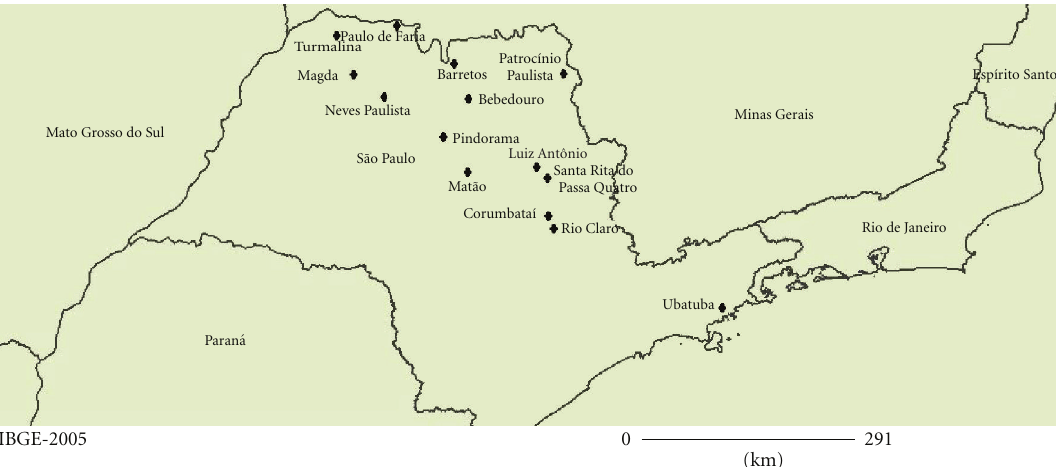
Figure 6: Map showing the localization of the areas of S˜ao Paulo state where surveys of social wasps were done.